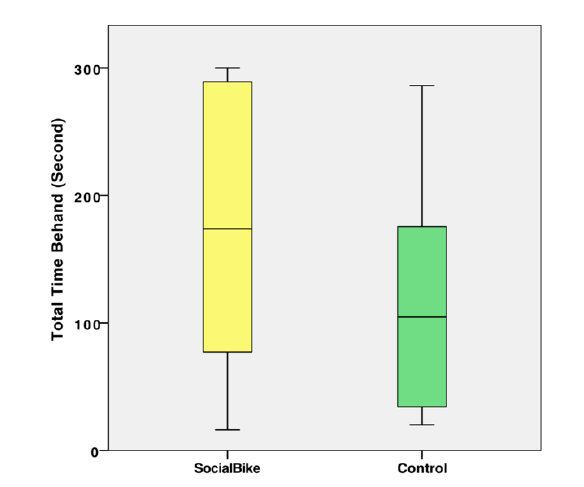
Figure. 21. The result of Average Distance Behind